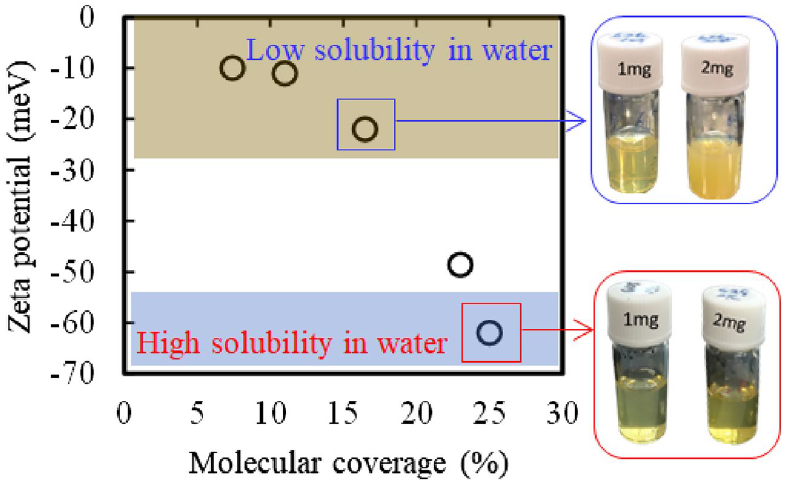
Figure 3. Changes in zeta-potential of SiQDs with increasing molecular coverage of 10-undecanoic acid monolayer. Digital photographs show the difference in transparency of SiQDs with different monolayer coverage dispersed in milli-Q water at 1.0 mg/mL and 2.0 mg/mL,